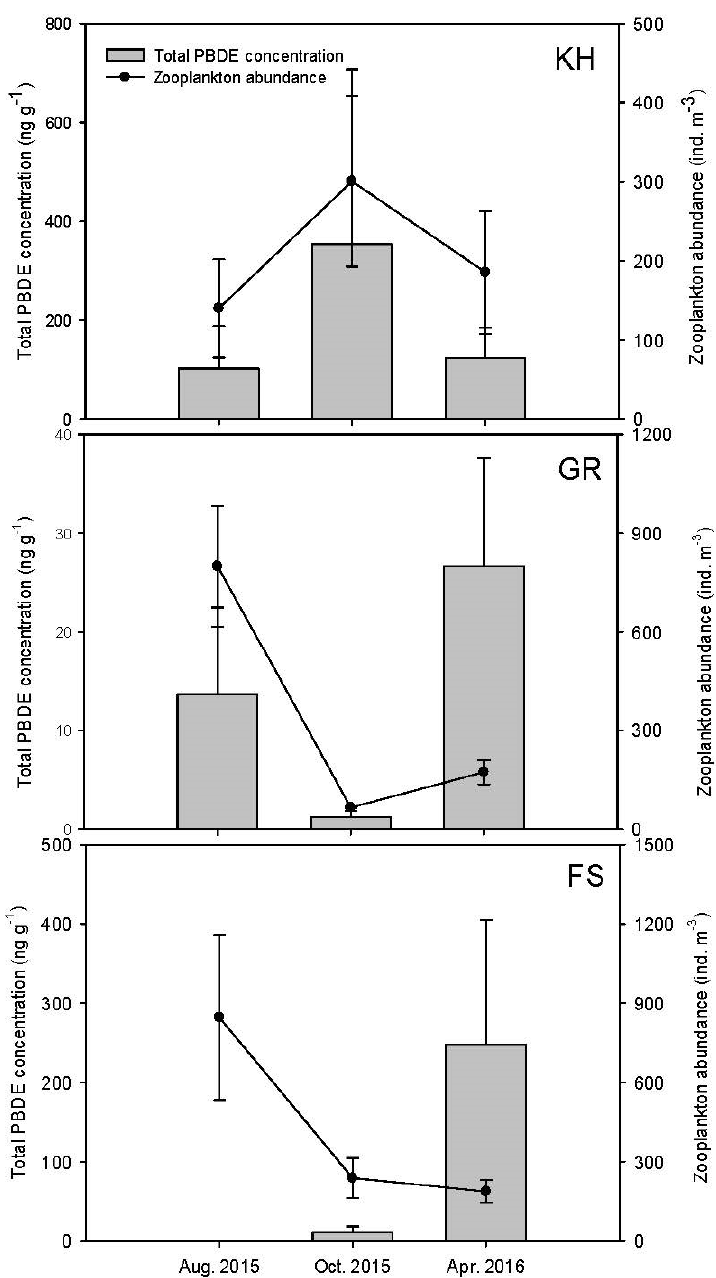
Figure 2. Mean values ( ± SE) of PBDE concentrations and zooplankton abundance levels in the Gaoping waters during the study period. KH: Kaohsiung Harbor; GR: Gaoping River estuary; FS: Fengshan Township. Table 2. Mean abundance (ind. m − 3 ) and total relative abundance (%) levels of zooplankton in the Gaoping waters during the study period. Note: –: no occurrence.